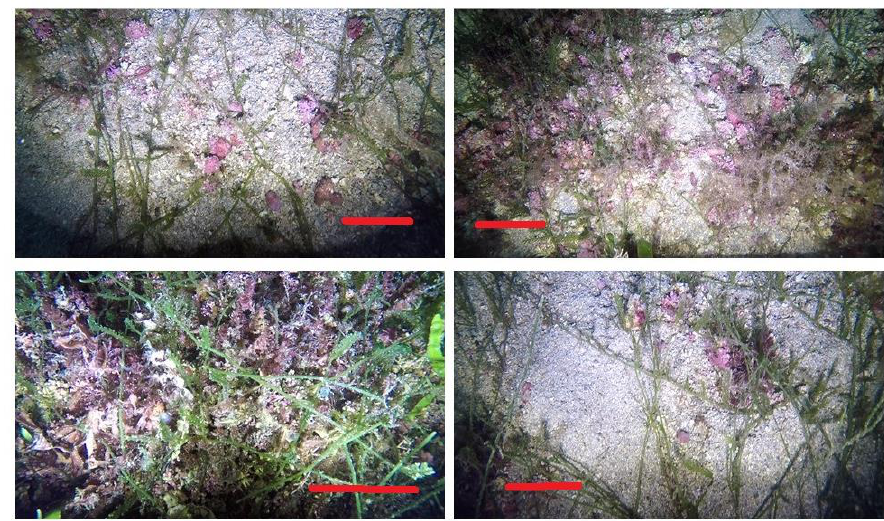
Figure 2. Examples of the photoframes extracted from videos. Red bars indicate the scale for each image.